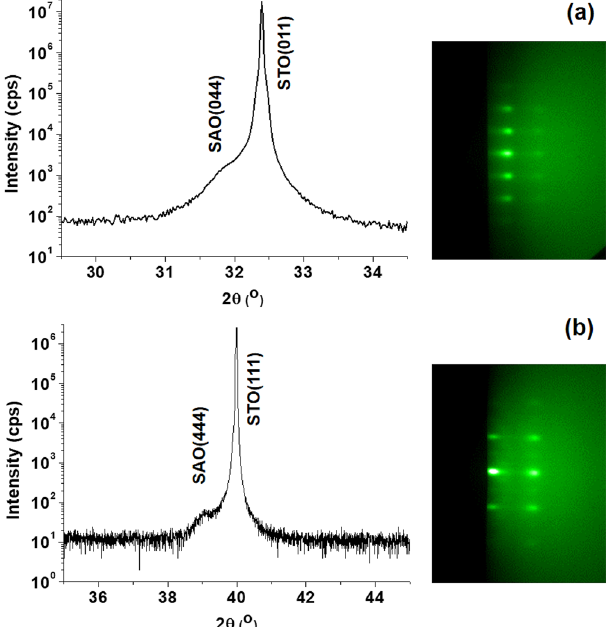
Figure 1. Epitaxial growth of SAO on STO(011) and STO(111) substrates. Panel ( a ) and ( b ) show XRD patterns of 100 nm SAO layers on STO(011) and STO(111) substrates, respectively, with capping STO layers. On the right-hand side, the spotty RHEED patterns of SAO layers were recorded along the [01-1]